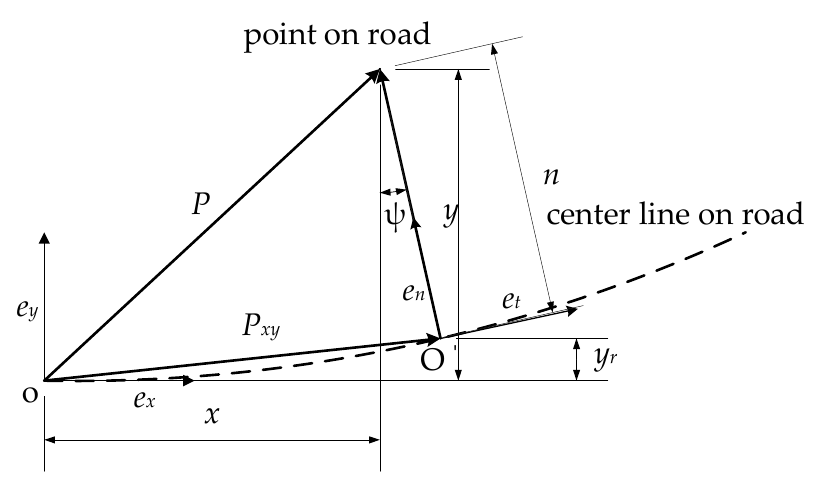
Figure 1. Curved road environment.